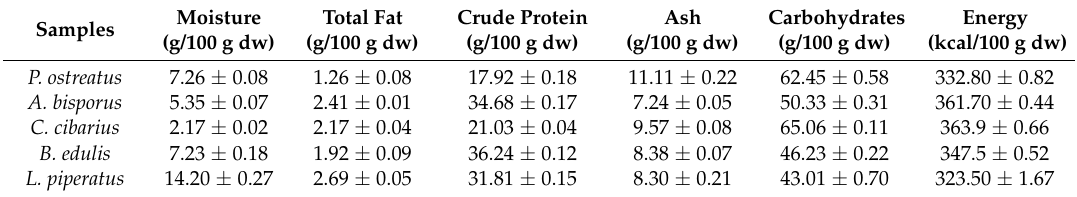
Table 1. Nutritional value of the studied wild edible mushrooms in